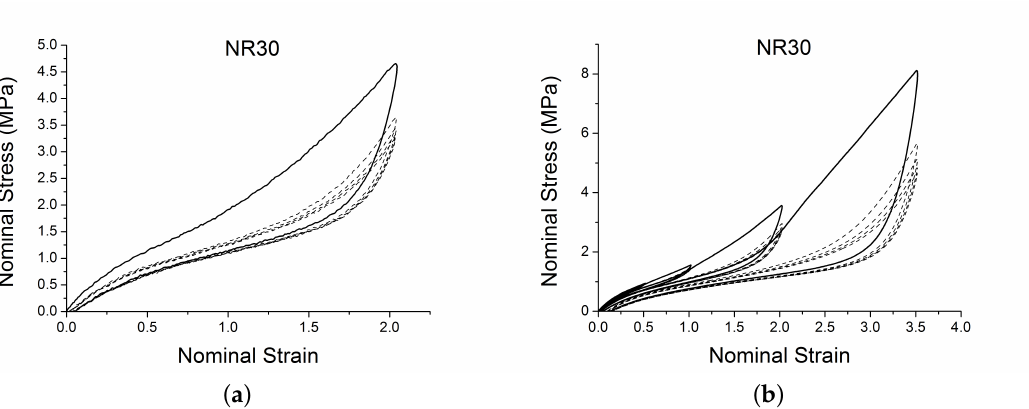
Figure 3. Stress–strain response of natural rubber filled with 30 phr of carbon black (NR30) submitted to cyclic uniaxial tension at 1.5/s. The solid curves are the trends for the first cycle at a given amplitude. The dotted curves are the trends after the initial cycle at given amplitude. ( a ) 5 cycles at the same amplitude, ( b ) 5 cycles at 4 different strain amplitude.